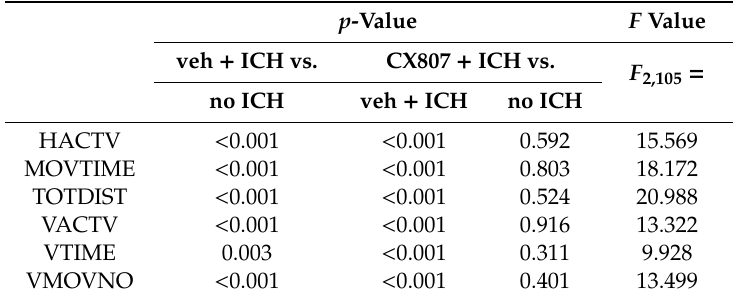
Table 1. Significant di ff erences in locomotor behaviors amongst all groups.